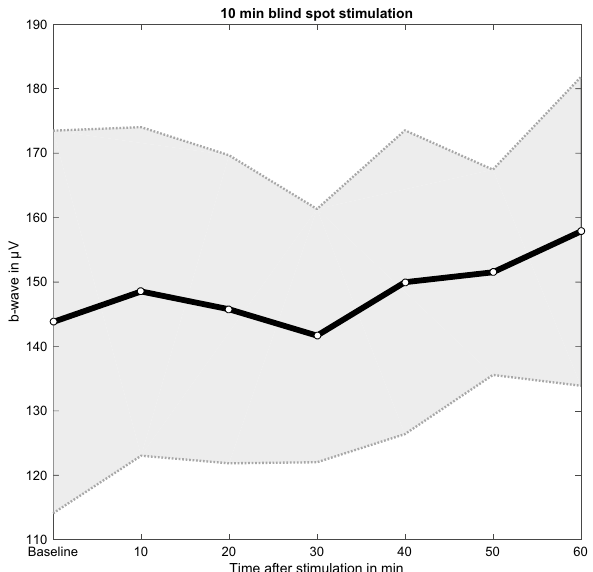
Figure 5. Mean and standard error of the mean (SEM) of the b-wave amplitude (µV) at baseline and 10, 20, 30, 40, 50, and 60 min after the 10 min blue light stimulation protocol.